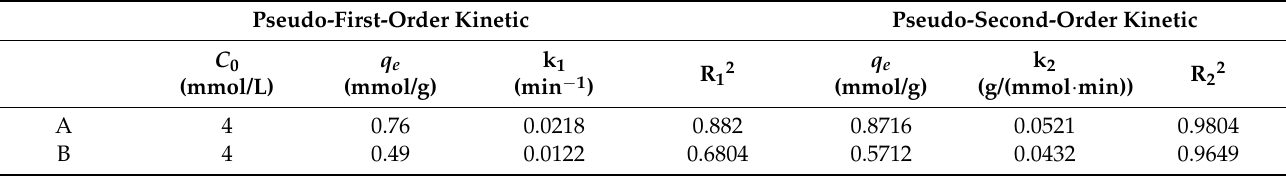
Table 3. Kinetic parameters for the adsorption of Cu (II) on shrimp shell (A) and MS (B). Pseudo-First-Order Kinetic